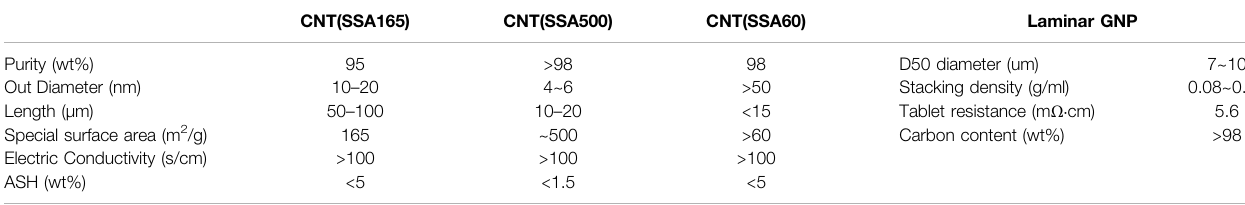
TABLE 1 | Basic information of CNTs with different SSA and laminar